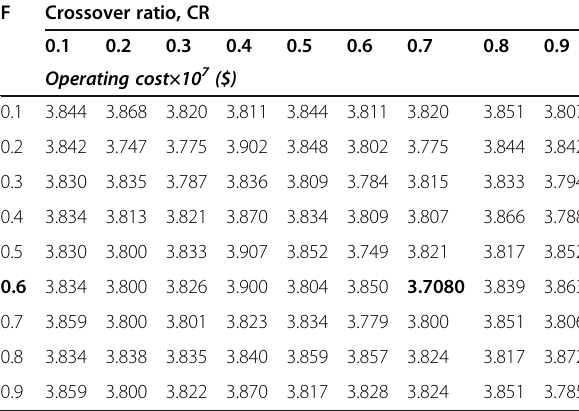
Table 7 Control of F and CR on DECSA for Indian 62 Bus practical